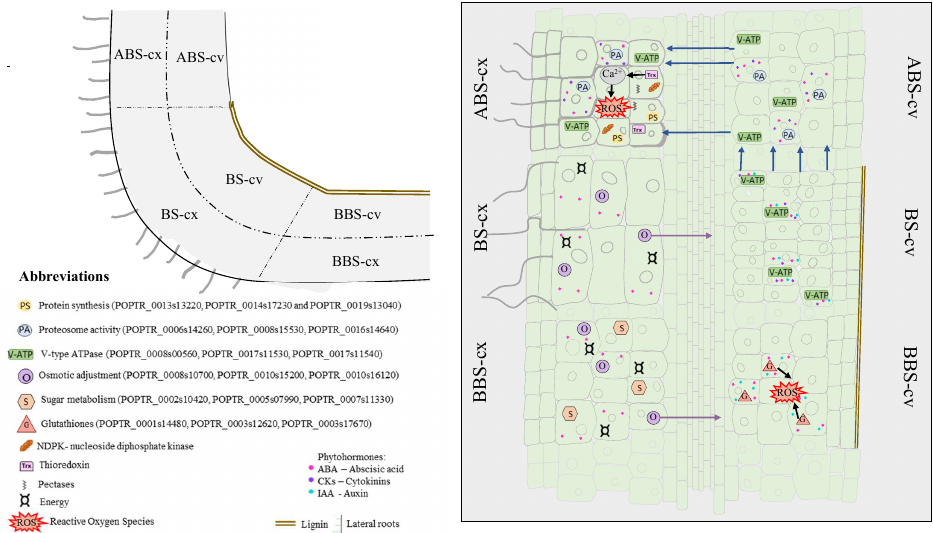
Figure 4. Schematic illustration of network and hub genes involved in spatial root response to mechanical constraints. Representative images summarize processes and pathways that characterize the different bent root sectors and sides. More details provided in the Conclusion section. ABS, above bending sector; BS, bending sector; BBS, below bending sector; cx, convex side; cv, concave